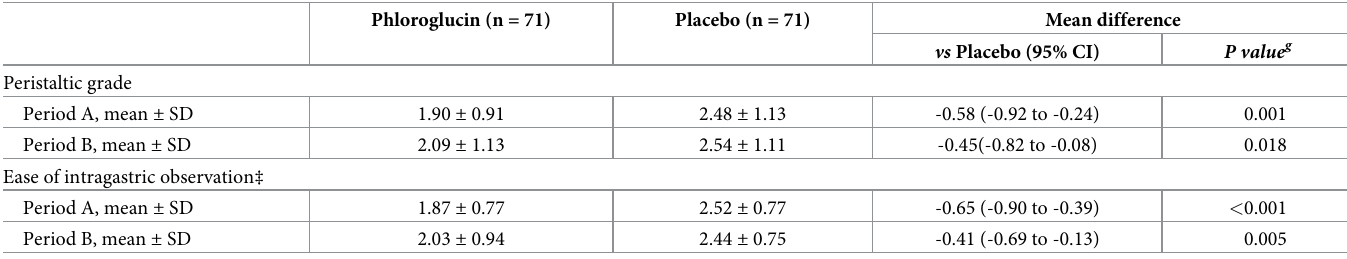
Table 3. Peristaltic grade e and the ease of intragastric observation f